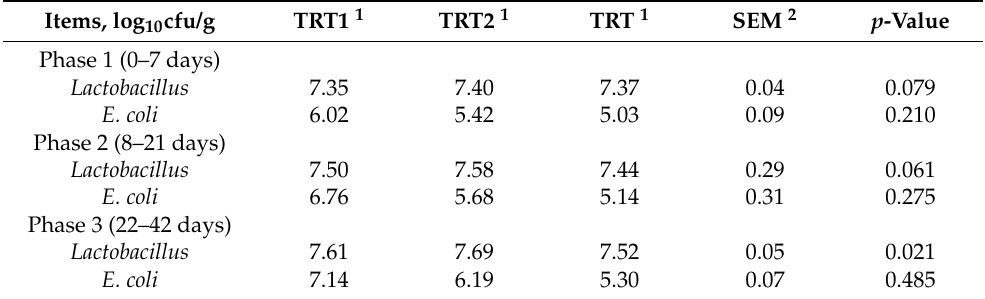
Table 4. Effect of blood plasma and yeast supplementation on the fecal microbial profile of weaning pigs 1 .